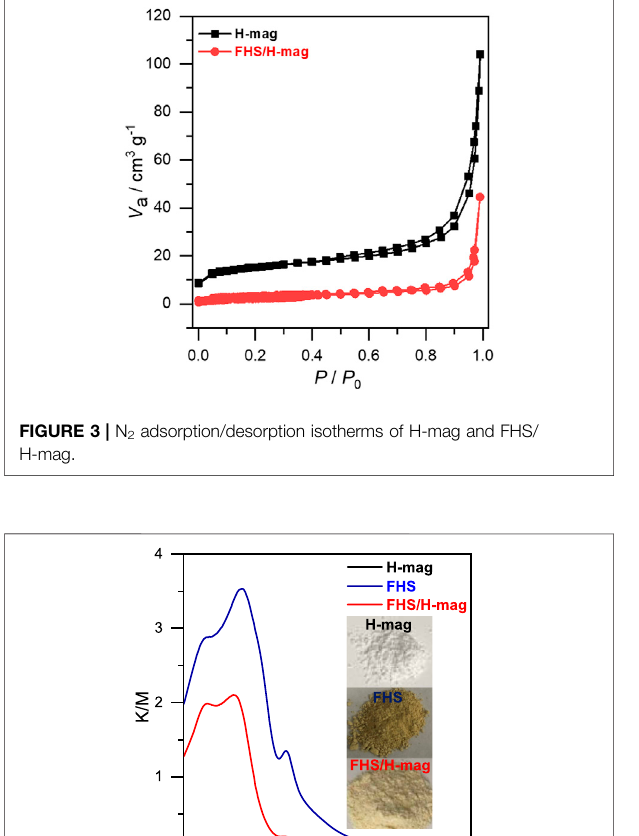
Frontiers in Energy Research |